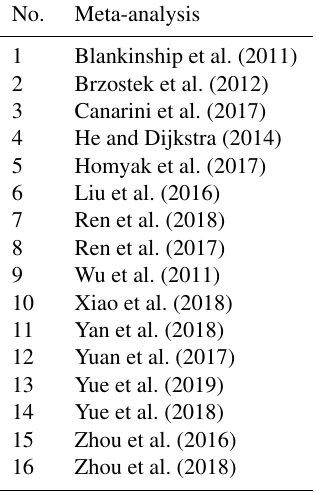
Table 1. List of meta-analyses used in this study.